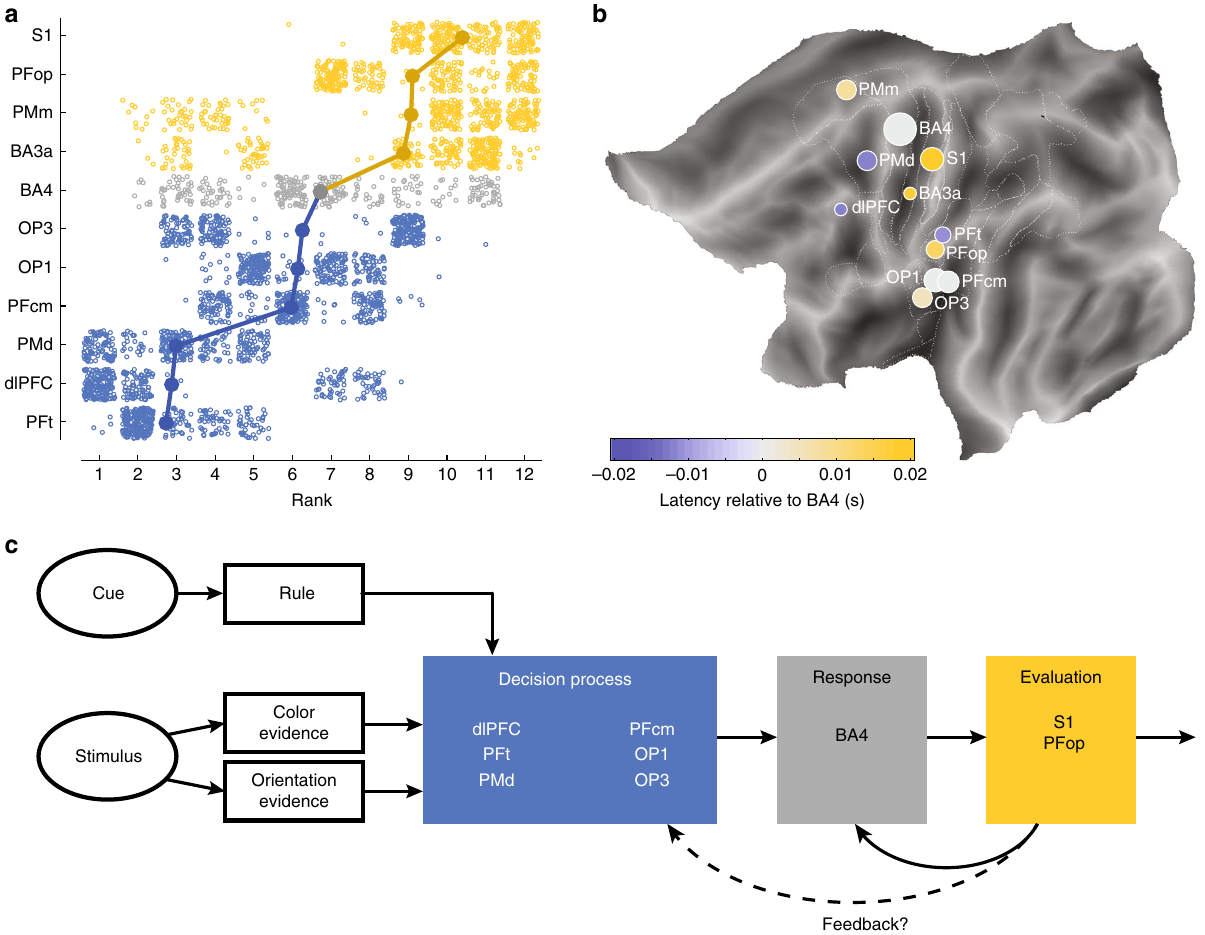
Fig. 5 Integration of the results of the four onset-tracking methods. a Rank distributions (i.e., ignoring the numerical value of onset) combined for all four methods from Fig. 4b – e, with each dot representing one bootstrap ( N = 86) from one method ( N = 4). All areas shown here achieved signi fi cant conjunction. Areas are ordered by their average rank; b average onset time of activation (color coded), relative to onset of area BA4, for all areas with signi fi cant consistency between methods. Each dot is located at the center of mass of all recording leads that contributed and the size of the circle represents the number of recording leads; c schematic of information fl ow suggested by the results in Figs. 3, and a and b : stimulus information and rule information all converge onto a shared decision process, consisting of an early (dlPFC, PFt, and PMd) and a late phase (PFcm, OP1, and OP3). See “ Discussion ” section for a detailed